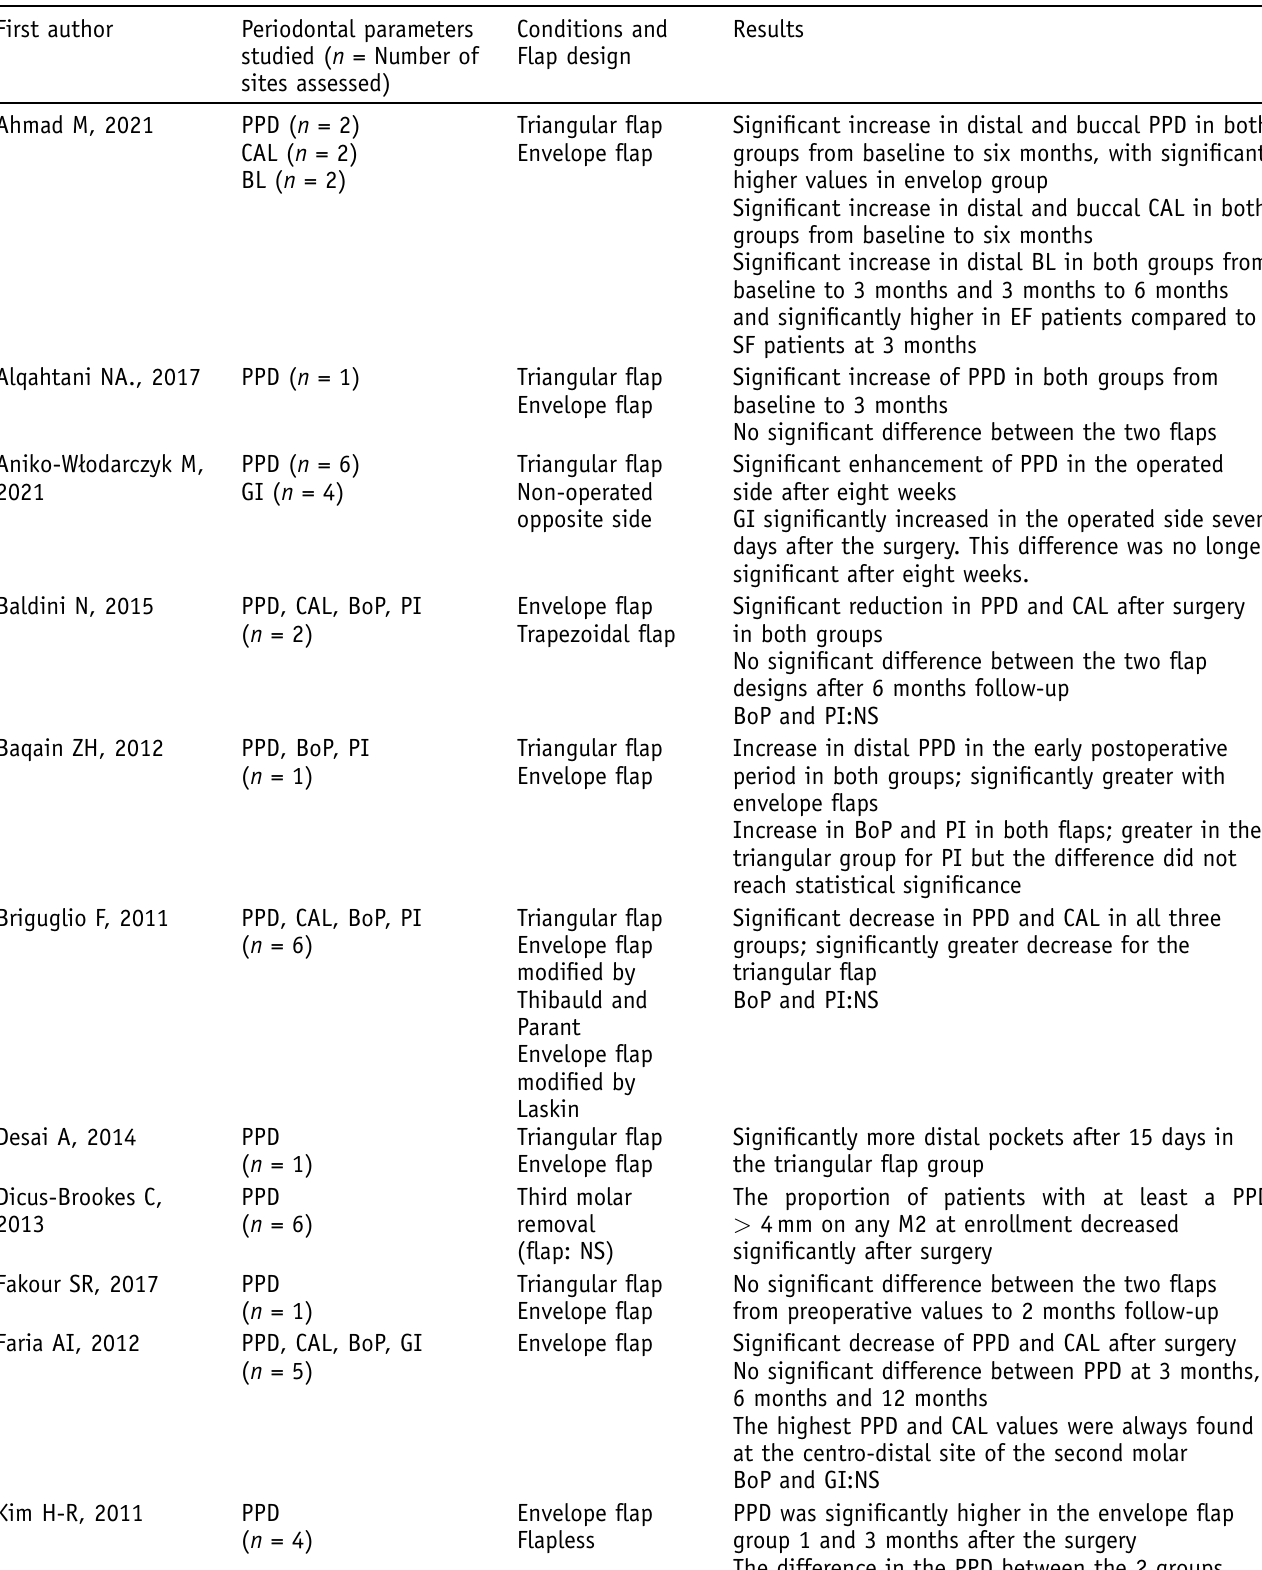
Table II. Details of periodontal parameters assessed and main results of the included